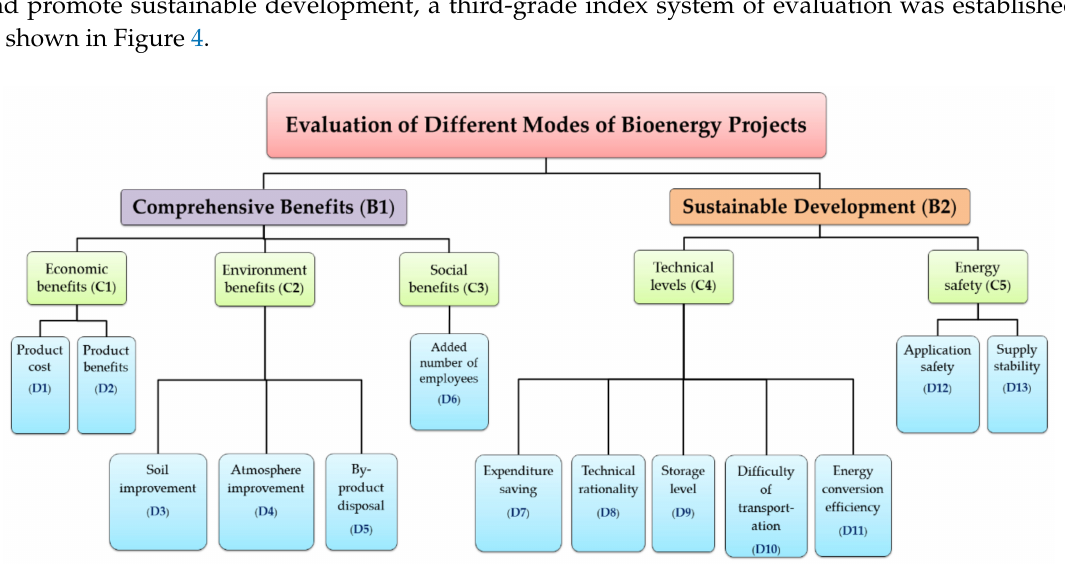
Figure 4. Evaluation index system for the project of crop residue